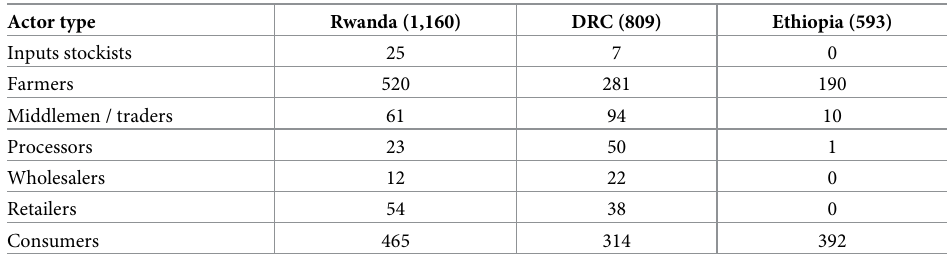
Table 1. Sample sizes across